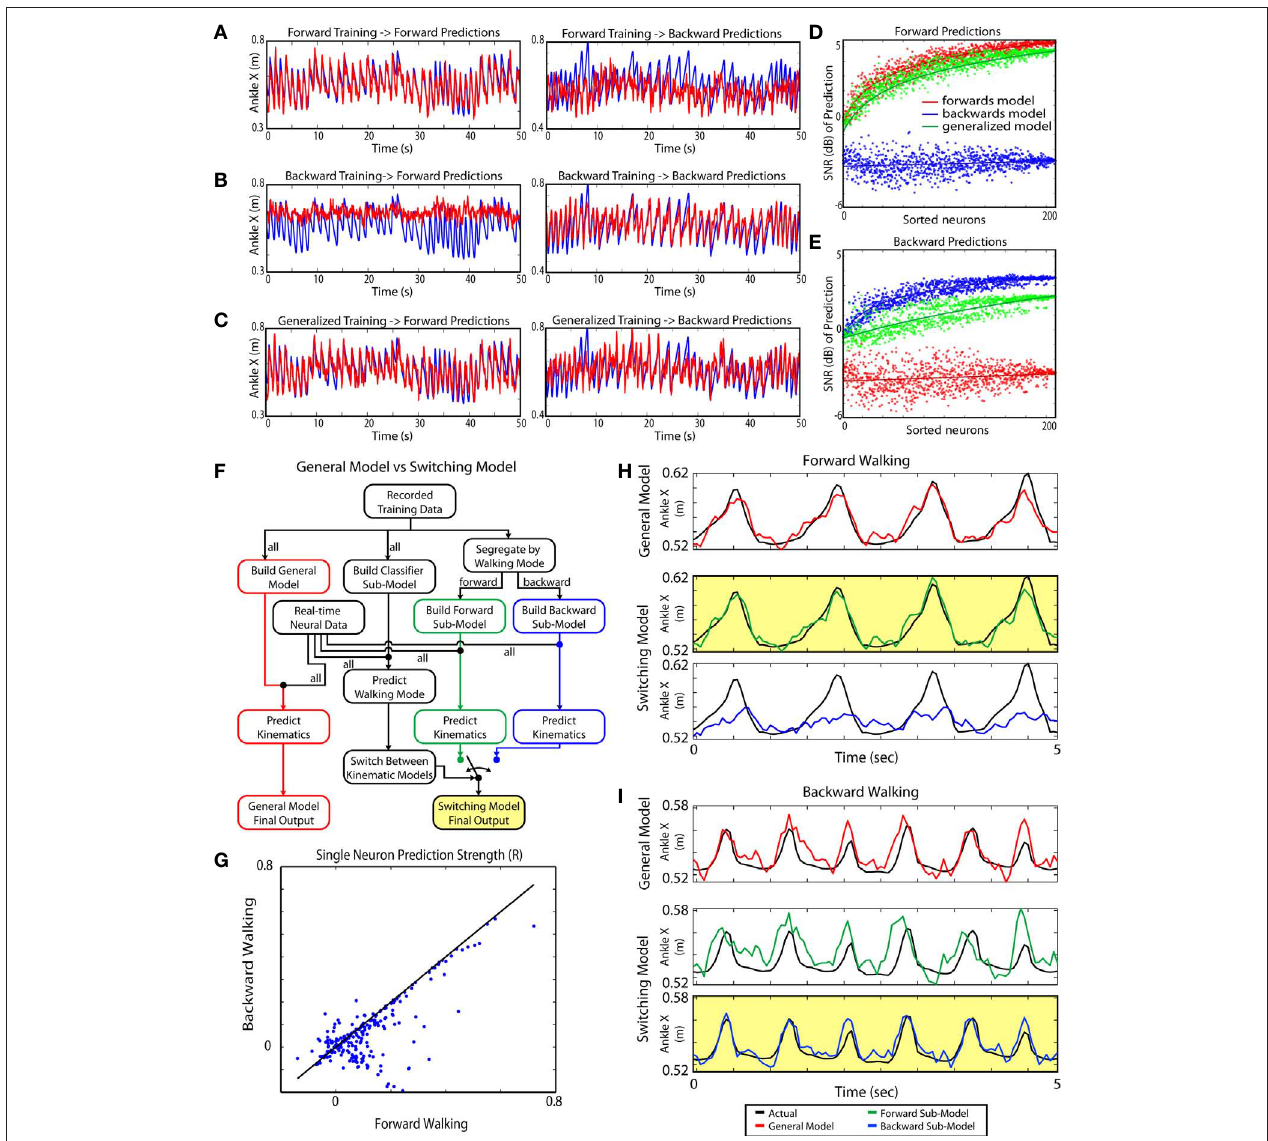
the switching model uses two separate kinematic submodels running in parallel. Each model is optimized for a separate walking paradigm: forward and backward walking. A state predictive model determines walking mode and selects which of the two kinematic submodels becomes the fi nal output. (G) Comparison of prediction strength of individual neurons during forward (abscissa) versus backwards (ordinate) walking. The prediction strength (R) was determined for single-neuron predictions of the X position of the ankle. While there is a general correlation between the Rs for these walking paradigms, there is a clear subpopulation of neurons with high Rs for forward, but not for backward walking. (H) Representative records of the X position of the ankle illustrating the predictive power of the switching model (the panel highlighted in yellow) versus generalized model (red curve) during forward walking. Note that the specialized model selected by the state predictive model (green curve) matches the original record (black curve) better than the generalized model (red curve) and the submodel for backward walking (blue curve). (I) Representative records for backward walking. The backward paradigm submodel selected by the state predictor (blue curve in the panel highlighted in yellow) matches the actual position (black curves) better than the generalized model (red curve) and the submodel for forward walking (green